Question: Sum up the contents of this chart in one sentence.
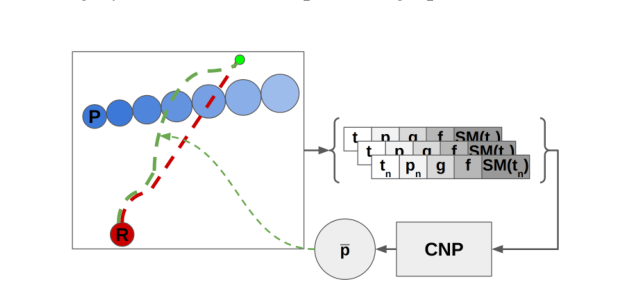
Answer: To include predicted future trajectories in the planning mechanism, the proposed approach is to feed them to the CNP-based LfD architecture. The neural network takes in tuples of the timestep, current position, navigation goal, the predicted trajectory of the pedestrian, and the robot’s trajectory within the next few time steps. It outputs the predicted trajectory in a local window, allowing it to be converted into a local planner.